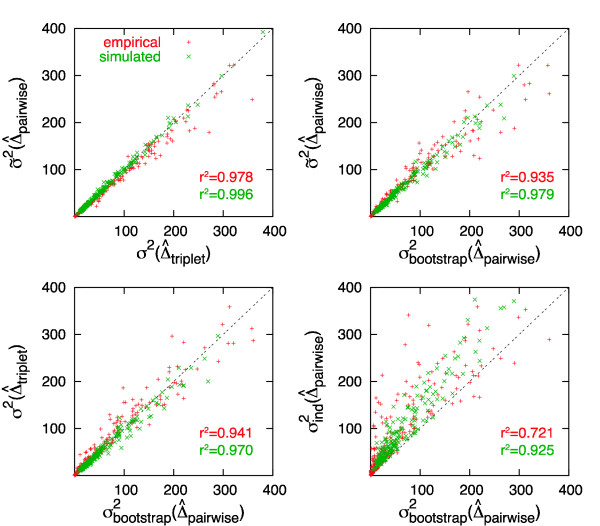
Scatter plots comparing the variance estimators. The upper-left plot shows the strong agreement between σ2(Δ^
 MathType@MTEF@5@5@+=feaafiart1ev1aaatCvAUfKttLearuWrP9MDH5MBPbIqV92AaeXatLxBI9gBaebbnrfifHhDYfgasaacH8akY=wiFfYdH8Gipec8Eeeu0xXdbba9frFj0=OqFfea0dXdd9vqai=hGuQ8kuc9pgc9s8qqaq=dirpe0xb9q8qiLsFr0=vr0=vr0dc8meaabaqaciaacaGaaeqabaqabeGadaaakeaacuqHuoargaqcaaaa@2E22@triplet) and our approximation σ2(Δ^
 MathType@MTEF@5@5@+=feaafiart1ev1aaatCvAUfKttLearuWrP9MDH5MBPbIqV92AaeXatLxBI9gBaebbnrfifHhDYfgasaacH8akY=wiFfYdH8Gipec8Eeeu0xXdbba9frFj0=OqFfea0dXdd9vqai=hGuQ8kuc9pgc9s8qqaq=dirpe0xb9q8qiLsFr0=vr0=vr0dc8meaabaqaciaacaGaaeqabaqabeGadaaakeaacuqHuoargaqcaaaa@2E22@pairwise). From the upper-right and the lower-left plots, it can be seen that both have similar correlation with σbootstrap2
 MathType@MTEF@5@5@+=feaafiart1ev1aaatCvAUfKttLearuWrP9MDH5MBPbIqV92AaeXatLxBI9gBaebbnrfifHhDYfgasaacH8akY=wiFfYdH8Gipec8Eeeu0xXdbba9frFj0=OqFfea0dXdd9vqai=hGuQ8kuc9pgc9s8qqaq=dirpe0xb9q8qiLsFr0=vr0=vr0dc8meaabaqaciaacaGaaeqabaqabeGadaaakeaaiiGacqWFdpWCdaqhaaWcbaGaemOyaiMaem4Ba8Maem4Ba8MaemiDaqNaem4CamNaemiDaqNaemOCaiNaemyyaeMaemiCaahabaGaeGOmaidaaaaa@3C22@(Δ^
 MathType@MTEF@5@5@+=feaafiart1ev1aaatCvAUfKttLearuWrP9MDH5MBPbIqV92AaeXatLxBI9gBaebbnrfifHhDYfgasaacH8akY=wiFfYdH8Gipec8Eeeu0xXdbba9frFj0=OqFfea0dXdd9vqai=hGuQ8kuc9pgc9s8qqaq=dirpe0xb9q8qiLsFr0=vr0=vr0dc8meaabaqaciaacaGaaeqabaqabeGadaaakeaacuqHuoargaqcaaaa@2E22@pairwise). Finally, the lower-right plot confirms that variance estimation under the assumption of independence can yield a large overestimation of the correct variance.